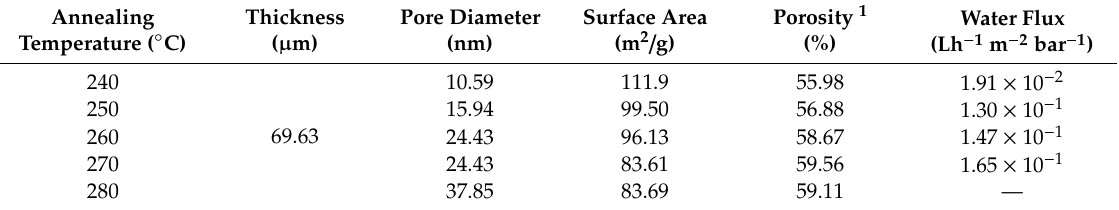
Figure 10. Pore size distribution of PEEK hollow fiber membrane prepared at different annealing temperatures ( a : 240 °C; b : 250 °C; c : 260 °C; d : 270 °C; e : 280 °C).